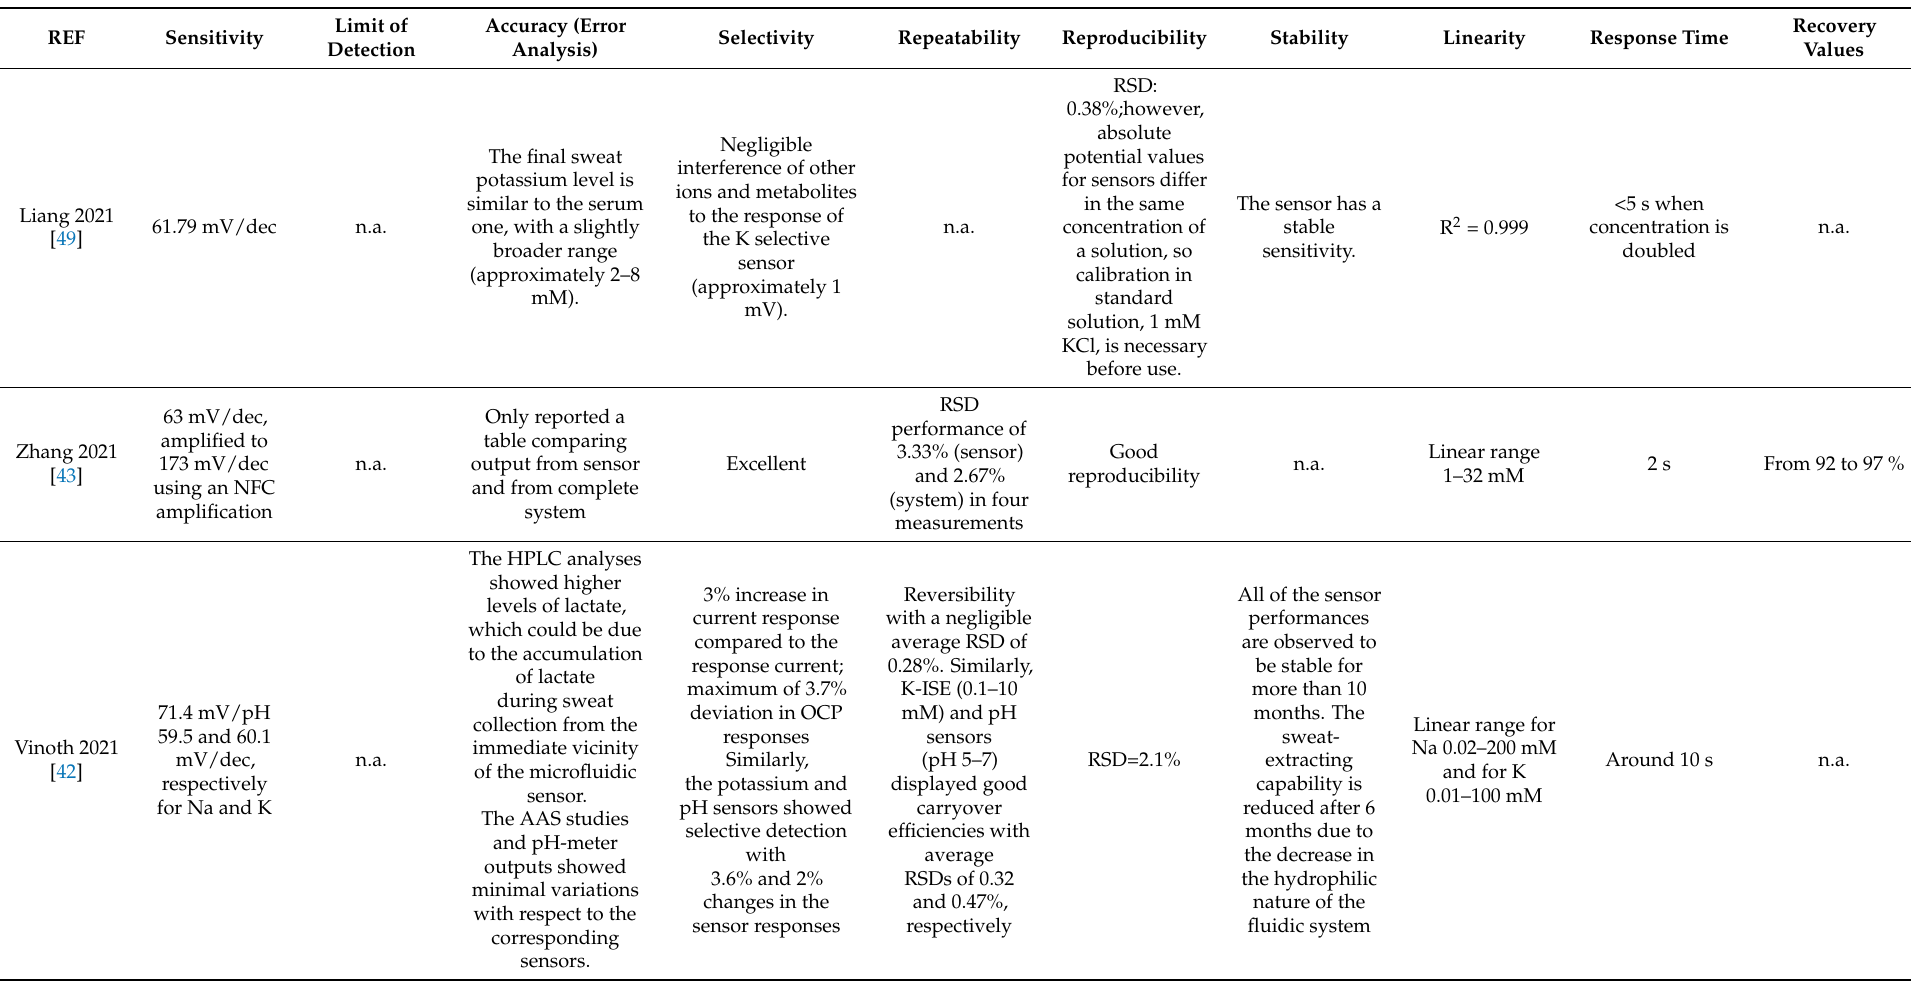
Table 6. Summary of in vivo characterization